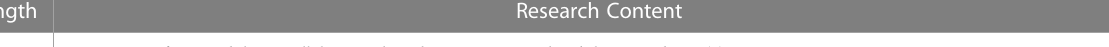
TABLE 5 The main contents of the 15 references with strong citations